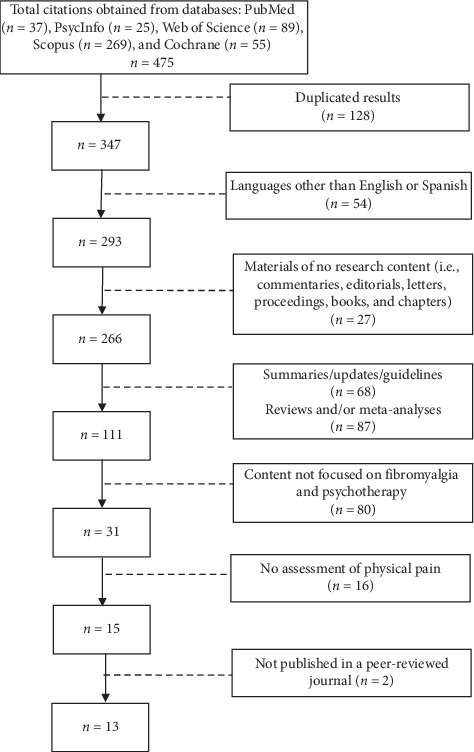
Study flow diagram.